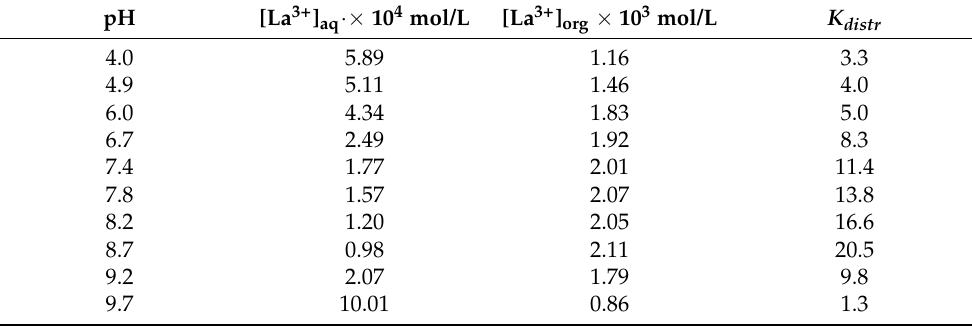
Table 2. The results of the experimental study of lanthanum (III) cations recovery to froth pulp in nitrate-chloride medium at the NaCl concentration of 0.05